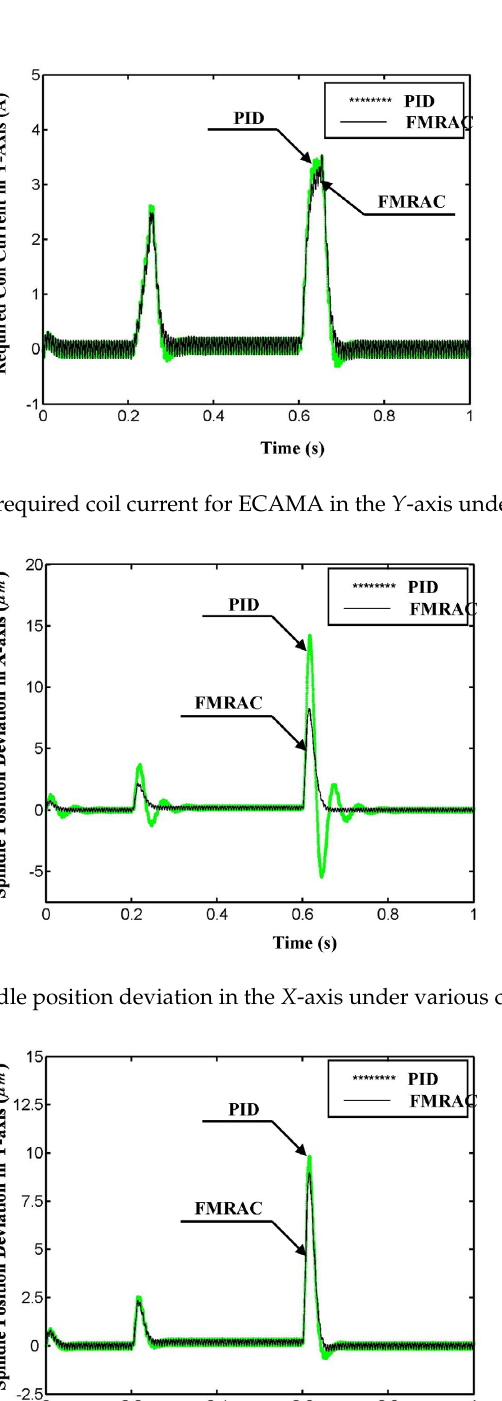
Figure 11. Comparison of required coil current for the ECAMA in the X -axis under various control laws.